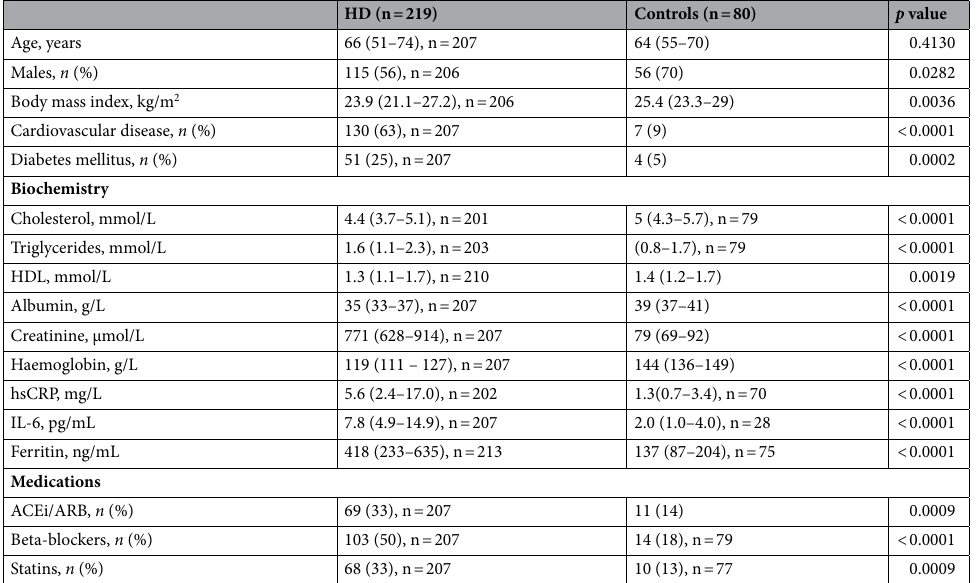
Table 1. Clinical characteristics of patient groups at baseline in non-chronic kidney disease (CKD) controls, haemodialysis (HD) used for peripheral biomarker assay. Data are presented as median and quartile range (Q1–Q3). Categorial data are presented as frequency (%). Continuous data analysed by non-parametric Mann–Whitney U test, and categorical data analysed by χ 2 . p value < 0.05. ACEi/ARB angiotensin converting enzyme inhibitors/angiotensin-receptor blockers, CKD chronic kidney disease, HD haemodialysis, HDL high- density lipoprotein, hsCRP high-sensitivity C-reactive protein, IL